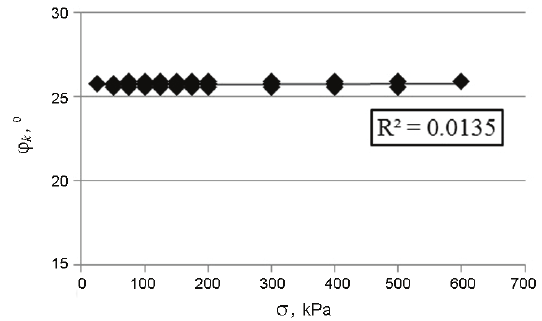
Fig. 18. The angle of internal friction versus vertical stress (results of 30 tests)